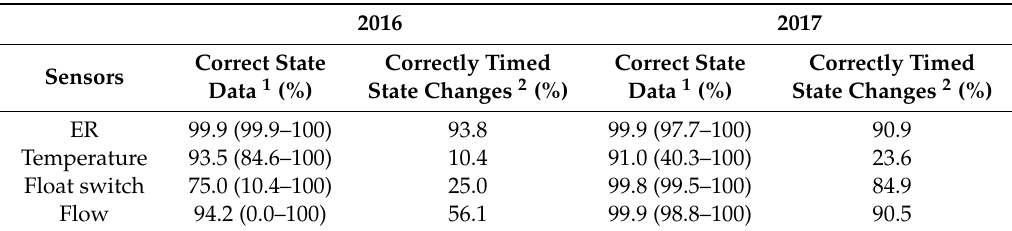
Table 2. Sensor performance for the 2016 and 2017 field seasons.